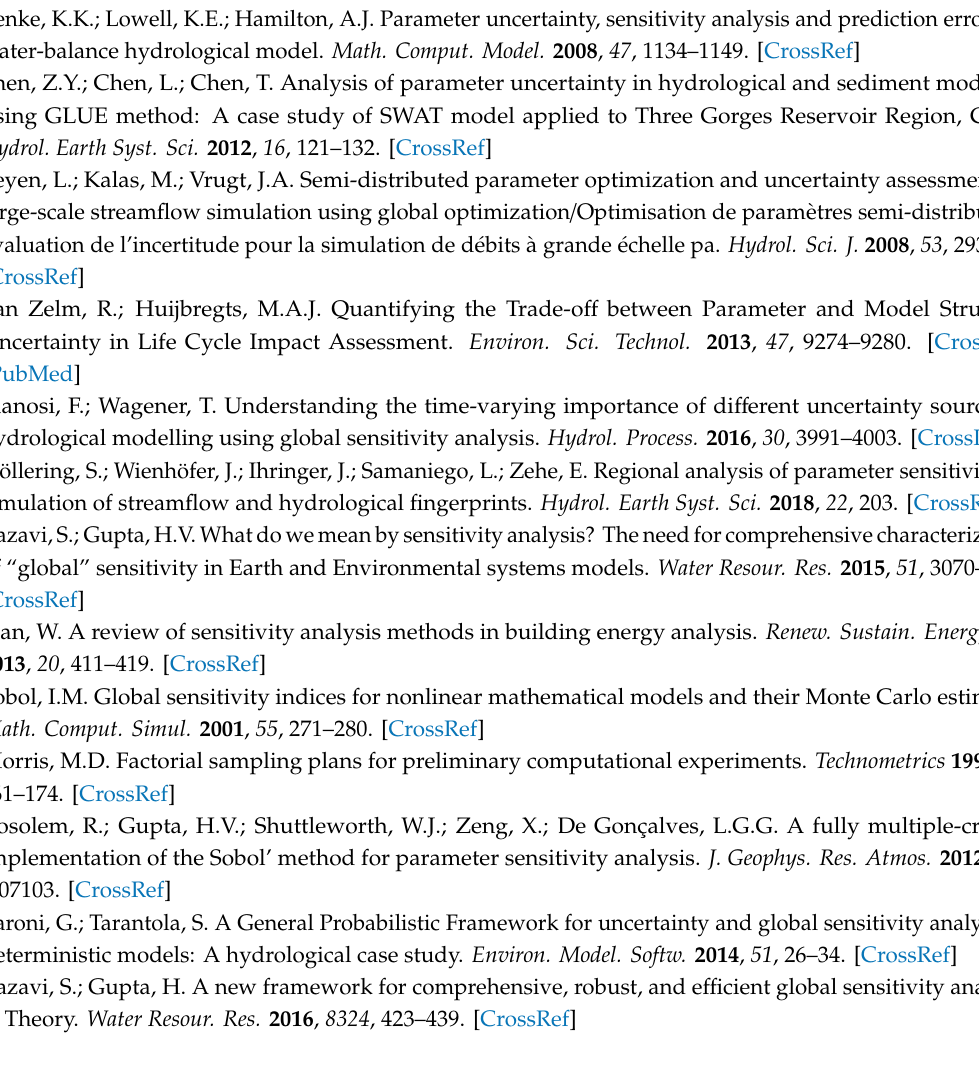
Figure S1: Delineation of Sub-basins in HYPE for Nelson Churchill River Basin, Figure S2: Ratio of factor sensitivity for moving windows of 30 days, 60 days, 90 days, 180 days and 360 days using NRMSE as the evaluation criteria from 2000-01-01 to 2005-11-29, Figure S3: Daily Average Annual Hydrograph (1981-2010) for simulated streamflow (best parameter set from sampling for Sensitivity Analysis) and observed streamflow for major river system within NCRB, Figure S4: Ratio of factor sensitivity for moving windows of 30 days, 60 days, 90 days, 180 days and 360 days using 3-day averaged Q 5 (high flow) as the evaluation criteria from 2000-01-01 to 2005-11-29, Table S1: Ranking of six most influential parameters (monthly) using di ff erent evaluation metrics (a) NSE (b) PBIAS (c) Q 95 , and (d)